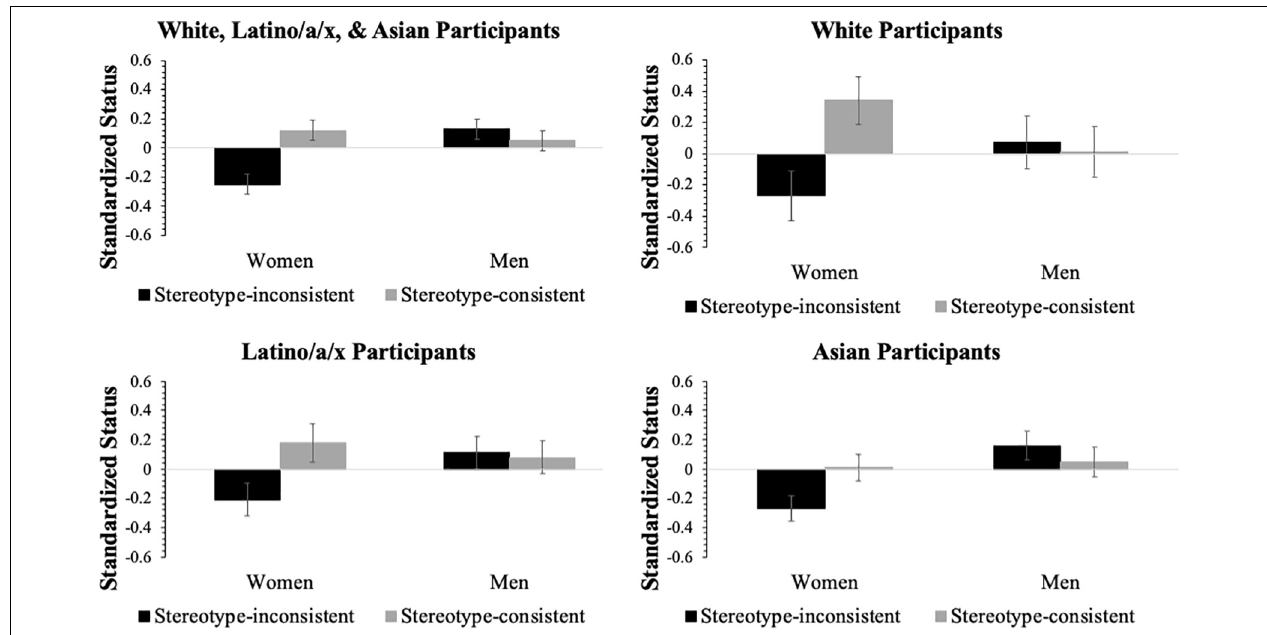
FIGURE 2 | Interactions between applicant gender and stereotype consistency by participant race. Error bars represent ± one standard